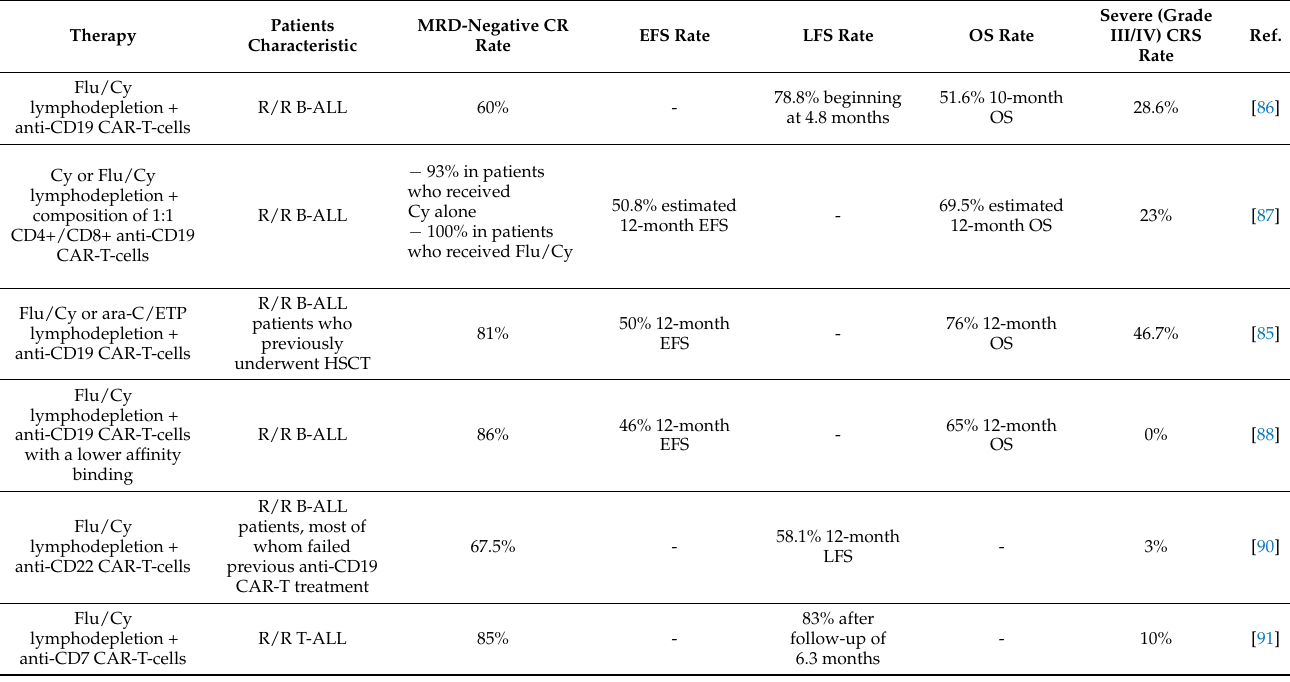
Table 2. Results of various CAR-T